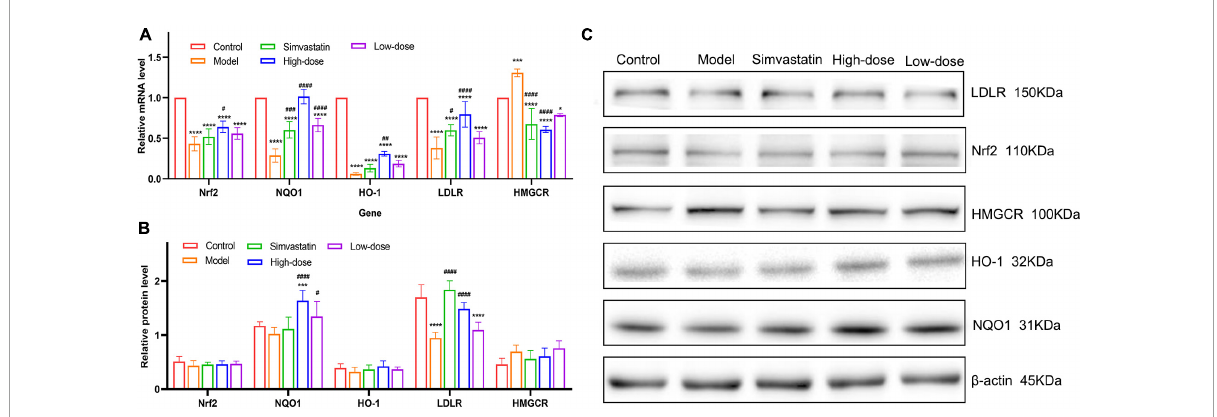
FIGURE6 Effect of HFA on protein and gene expression in HepG2 cells. (A) Relative mRNA expression levels of Nrf2, NQO1, HO-1, LDLR, and HMGCR were quantified by RT-qPCR; (B,C) Protein expression levels of Nrf2, NQO1, HO-1, LDLR, and HMGCR. Data represent mean ± SD ( n = 3). Statistically significant results were indicated as * p < 0.05, ** p < 0.01, *** p < 0.001, and **** p < 0.0001 vs. control group; # p < 0.05, ## p < 0.01, ### p < 0.001, and #### p < 0.0001 vs. model